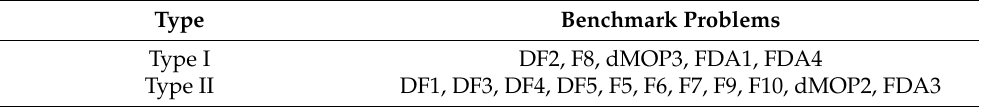
Table 1. Overview of benchmark